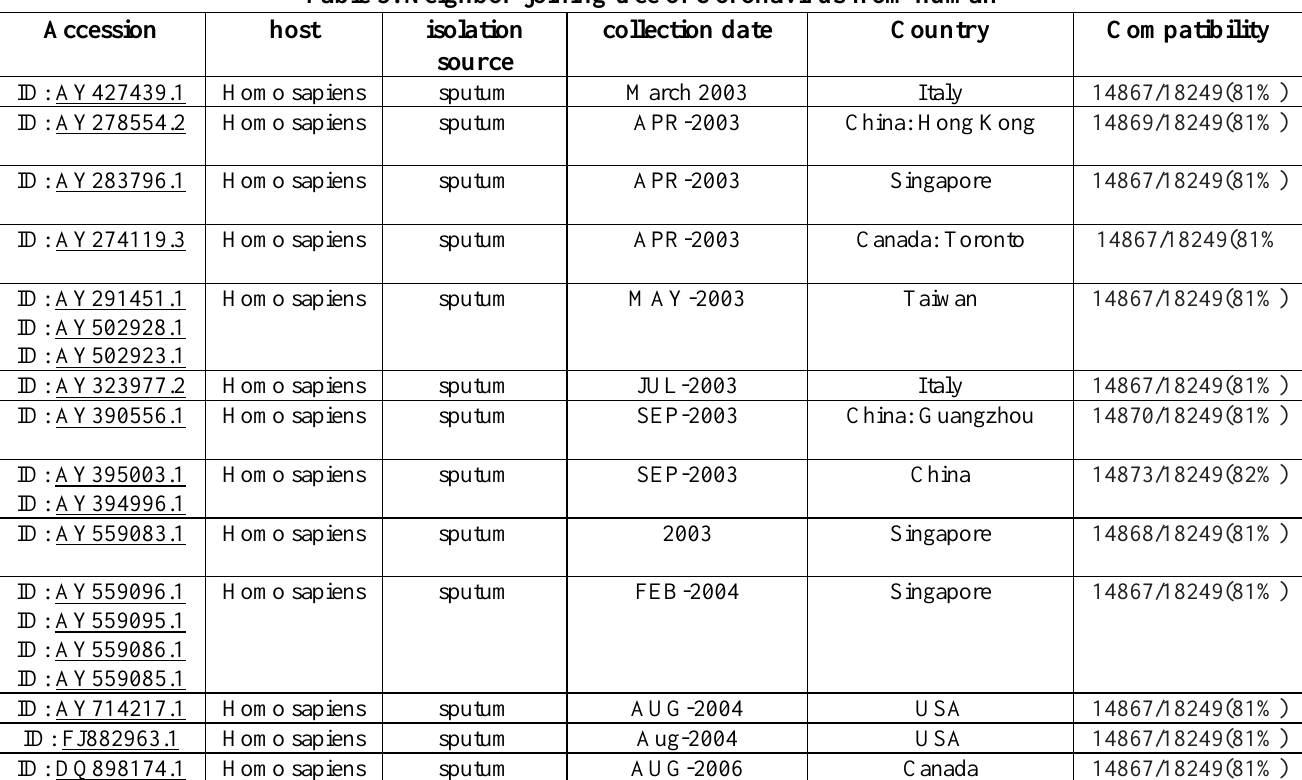
Table 3. Neighbor-joining tree of Coronavirus from